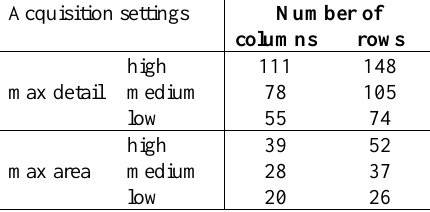
Table 2 . Number of rows and columns of the Apple LiDAR matrix for each quality setting in SiteScape.